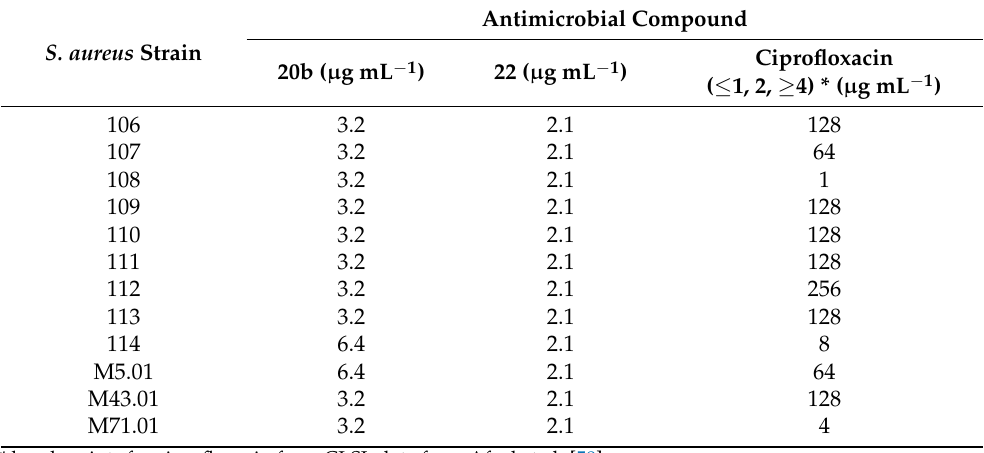
Table 2. MIC values of compounds 20b and 22 against 12 S. aureus strains that were isolated from